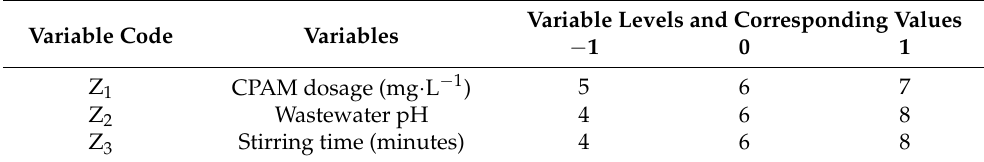
Table 2. Experimental levels of independent test variables.